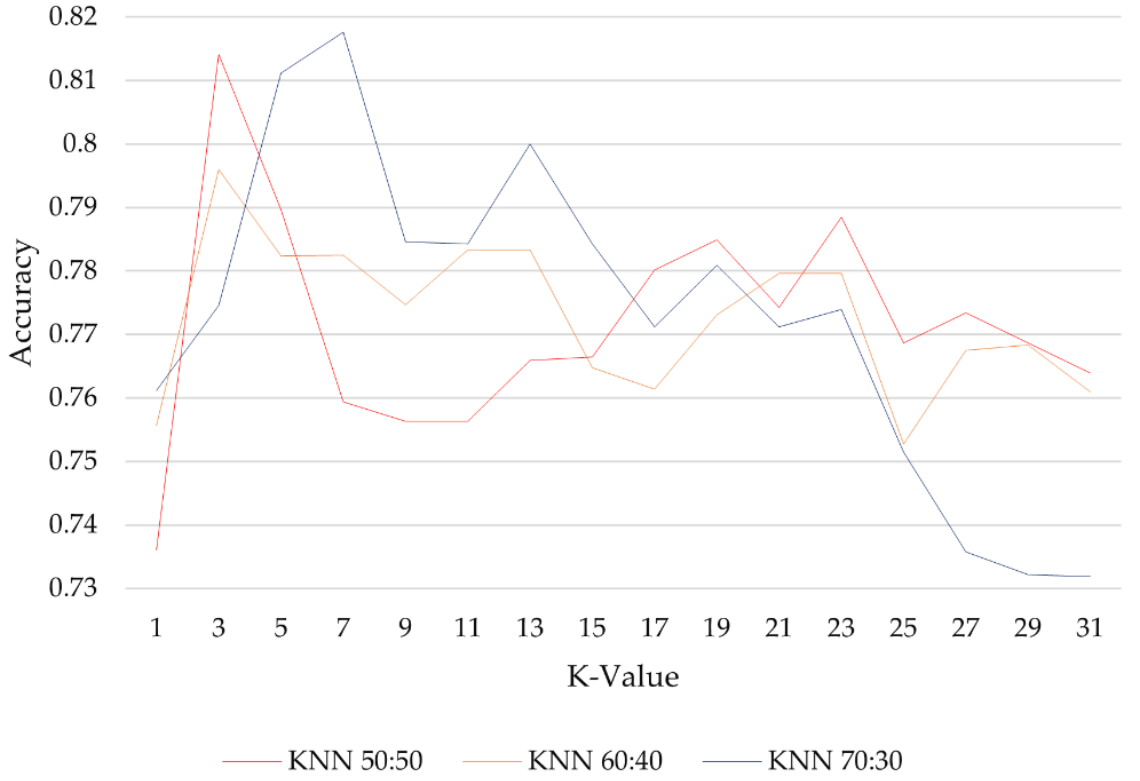
Figure 4. Cross-validation to obtain the best k value for each scenario of the KNN algorithm. The KNN yields probability values of landslides from 0 to 1. The average probability values of the KNN 50:50, KNN 60:40, and KNN 70:30 models are 0.449, 0.338, and 0.365, respectively. The probability values are then classified into low susceptibility (0–0.3),